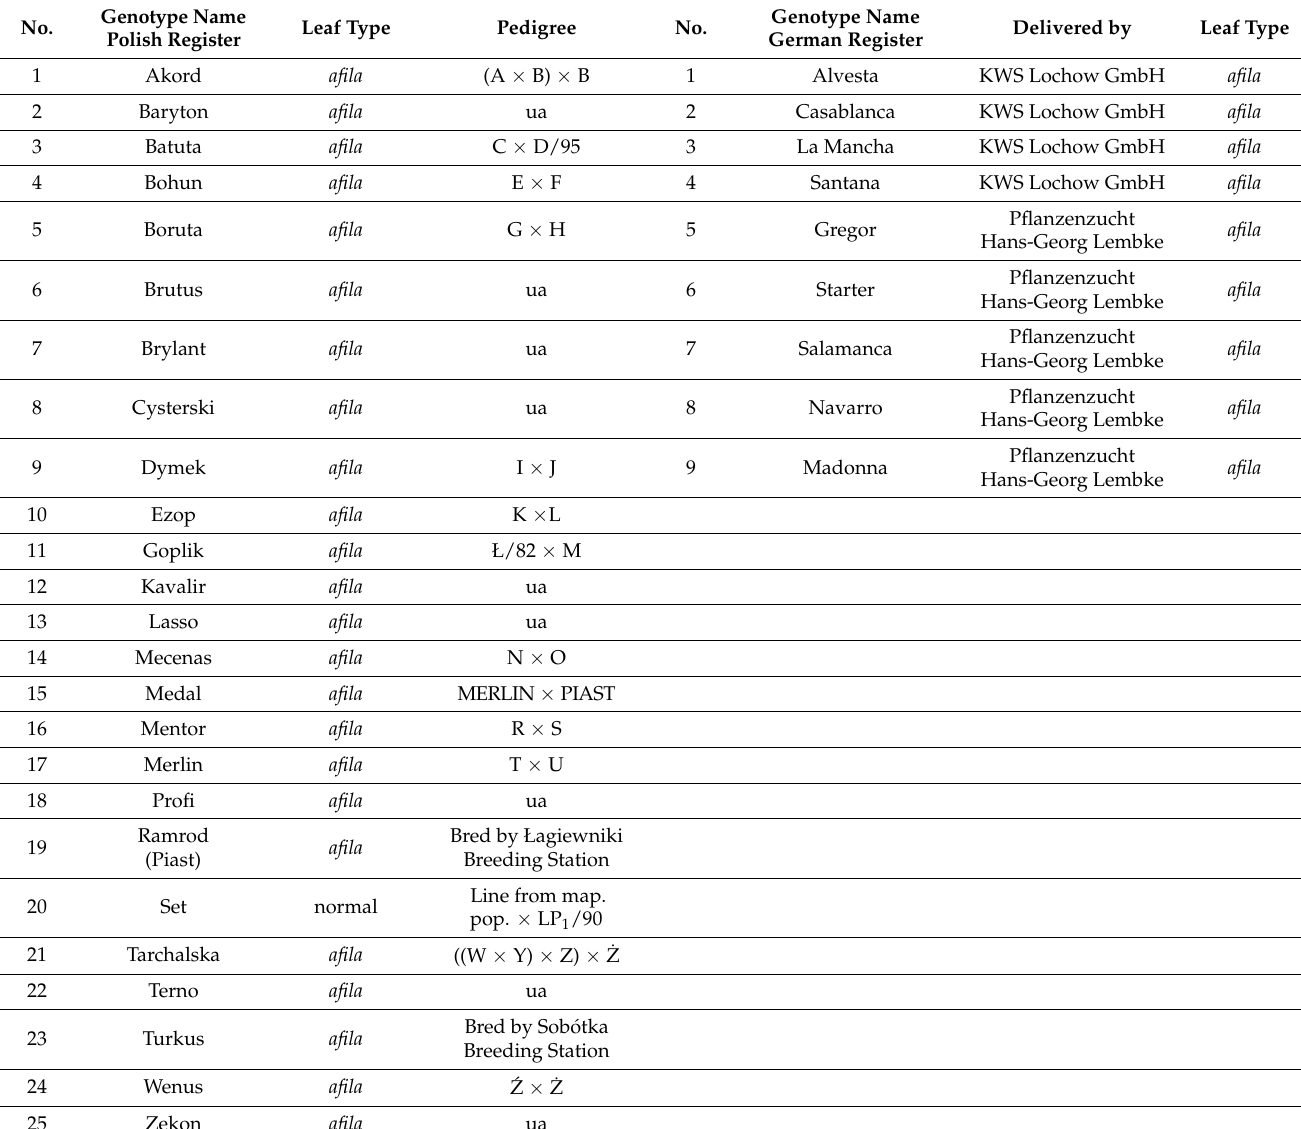
Table 1. Analyzed pea cultivars from the Polish and German